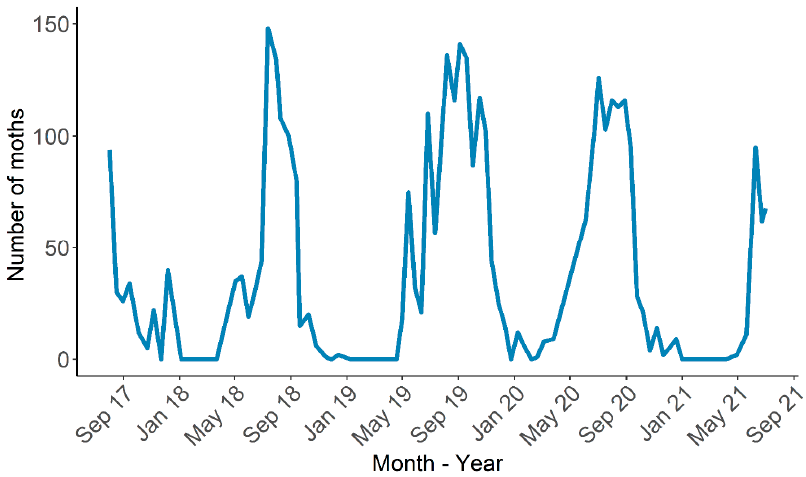
Figure 1. Number of LCSB male moths collected in delta traps according to the month of the year at Jay, Santa Rosa County, Florida.